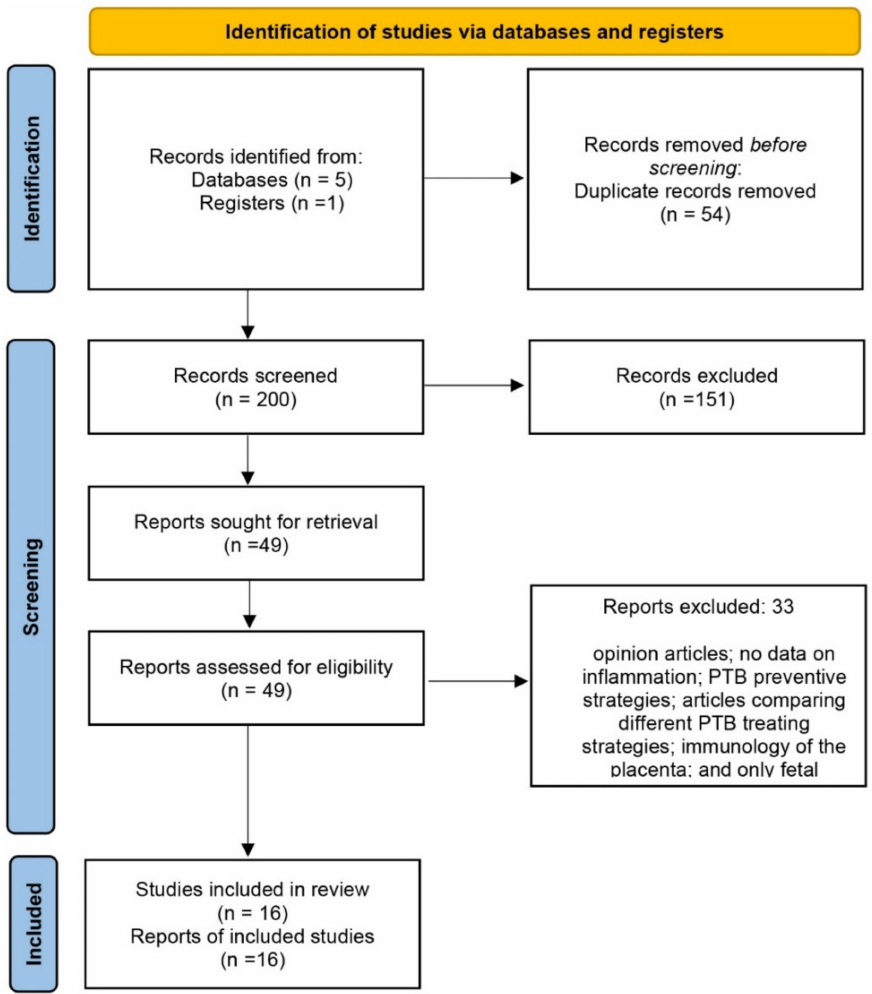
Figure 1. PRISMA flow